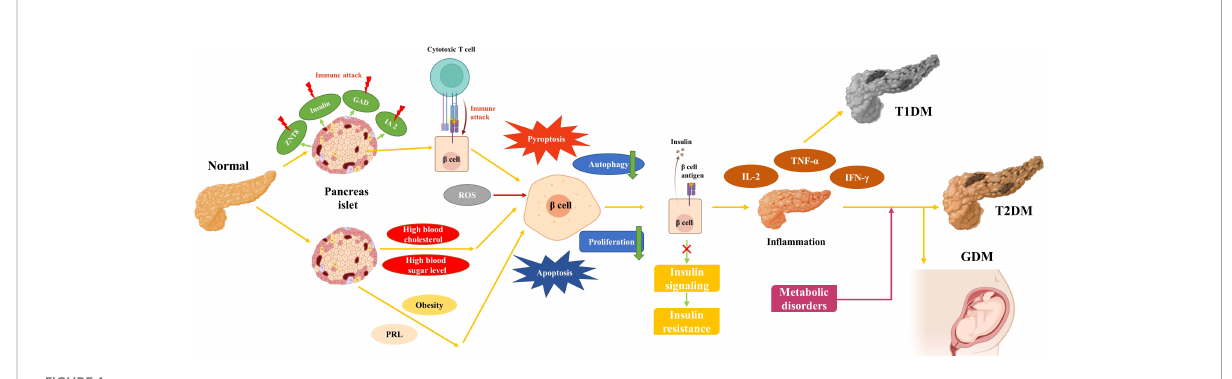
FIGURE 1 Development of T1DM, T2DM, and